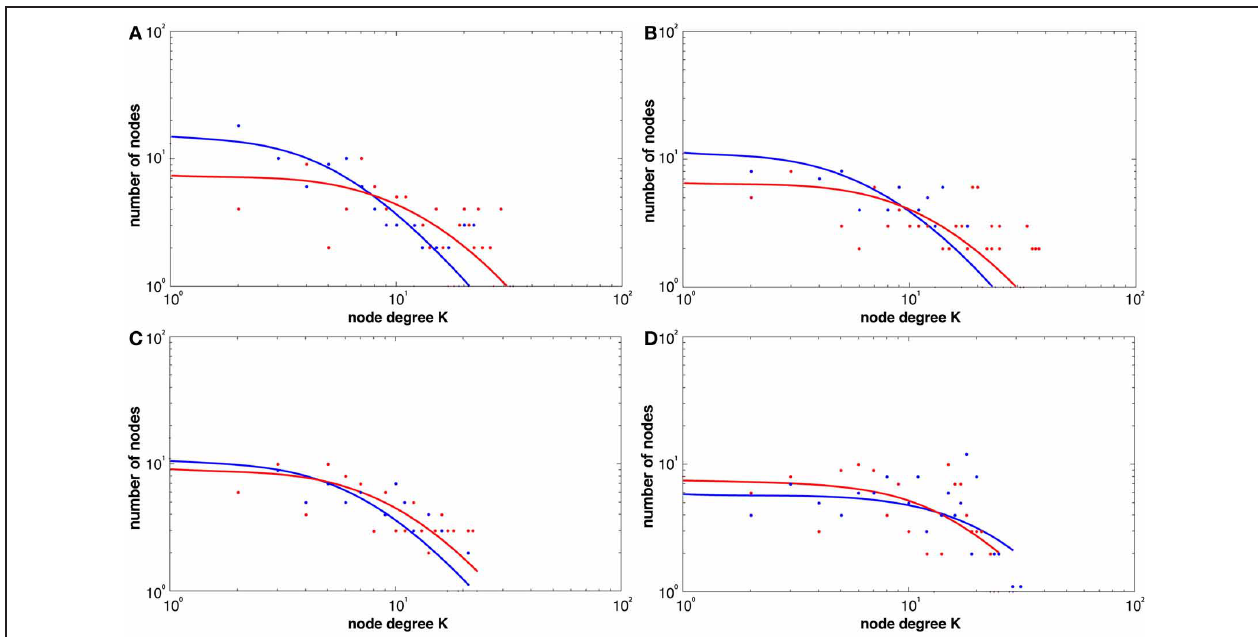
FIGURE 5 | Histogram degree distributions before and following the four tasks at a threshold of r = 0 . 6 for both REST1 (blue) and REST2 (red), (A) explicit SRTT (B) implicit SRTT task (C)